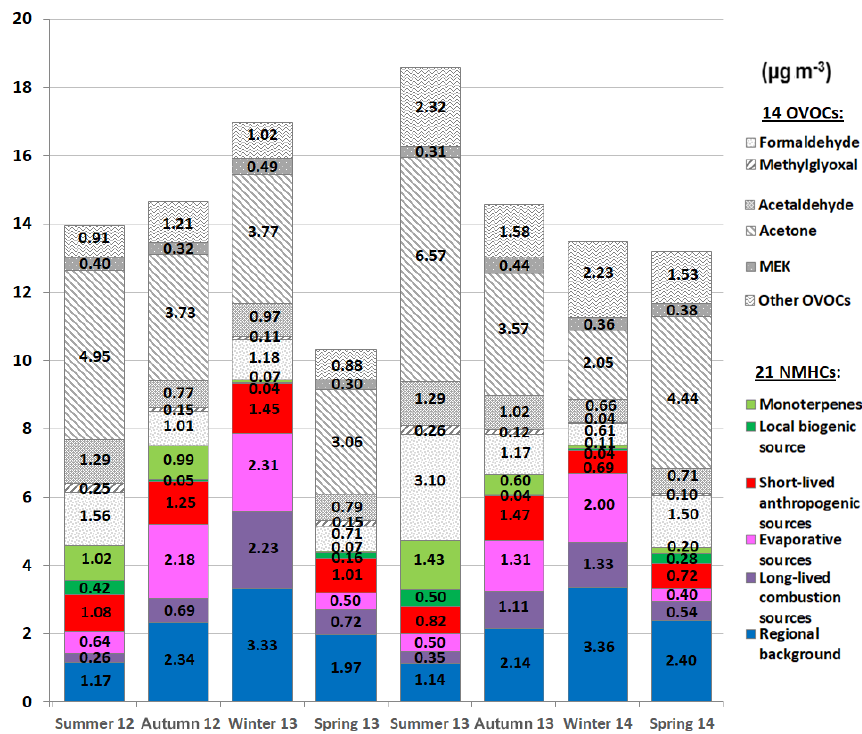
Figure 10. Variations in seasonal averaged accumulated concentrations (expressed in µgm − 3 ) of the 35 VOCs selected in this study. The 17 NHMCs selected in the factorial analysis were apportioned to the five modelled NMHC sources. NMHC seasonal measured concentrations which were not modelled by the PMF tool were lower than 0.09µgm − 3 and are not reported here. Winter: 1 January–31 March periods – spring: 1 April–30 June periods – summer: 1 July–30 September periods – autumn: 1 October–31 December periods. Note that the VOC dataset included different sampling time hours (09:00–13:00 or 12:00–16:00UTC) following shifts during the 2-year period (see Table